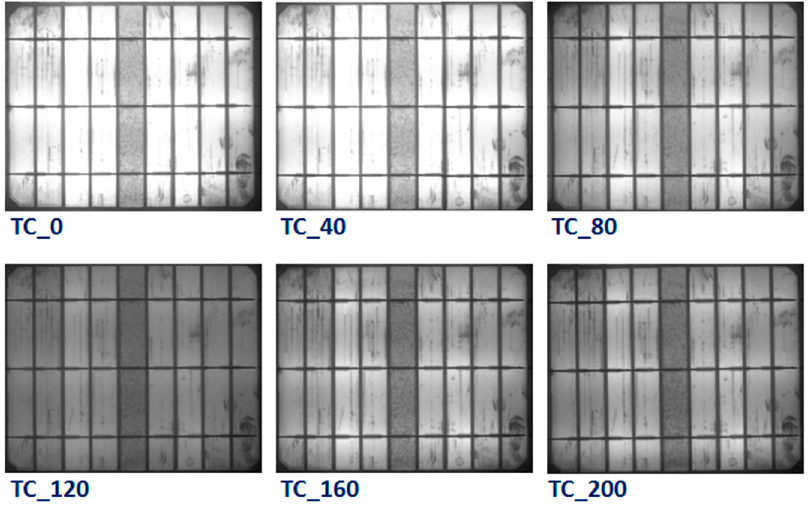
Figure 8. Electroluminescence images of PV modules with concrete after various thermal cycling tests (0, 40, 80, 120, 160, and 200 cycles).